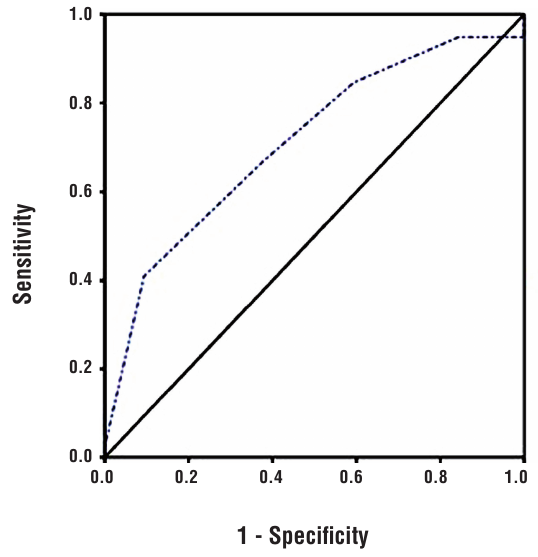
figure 2- ROc curve: REnAL x conversion